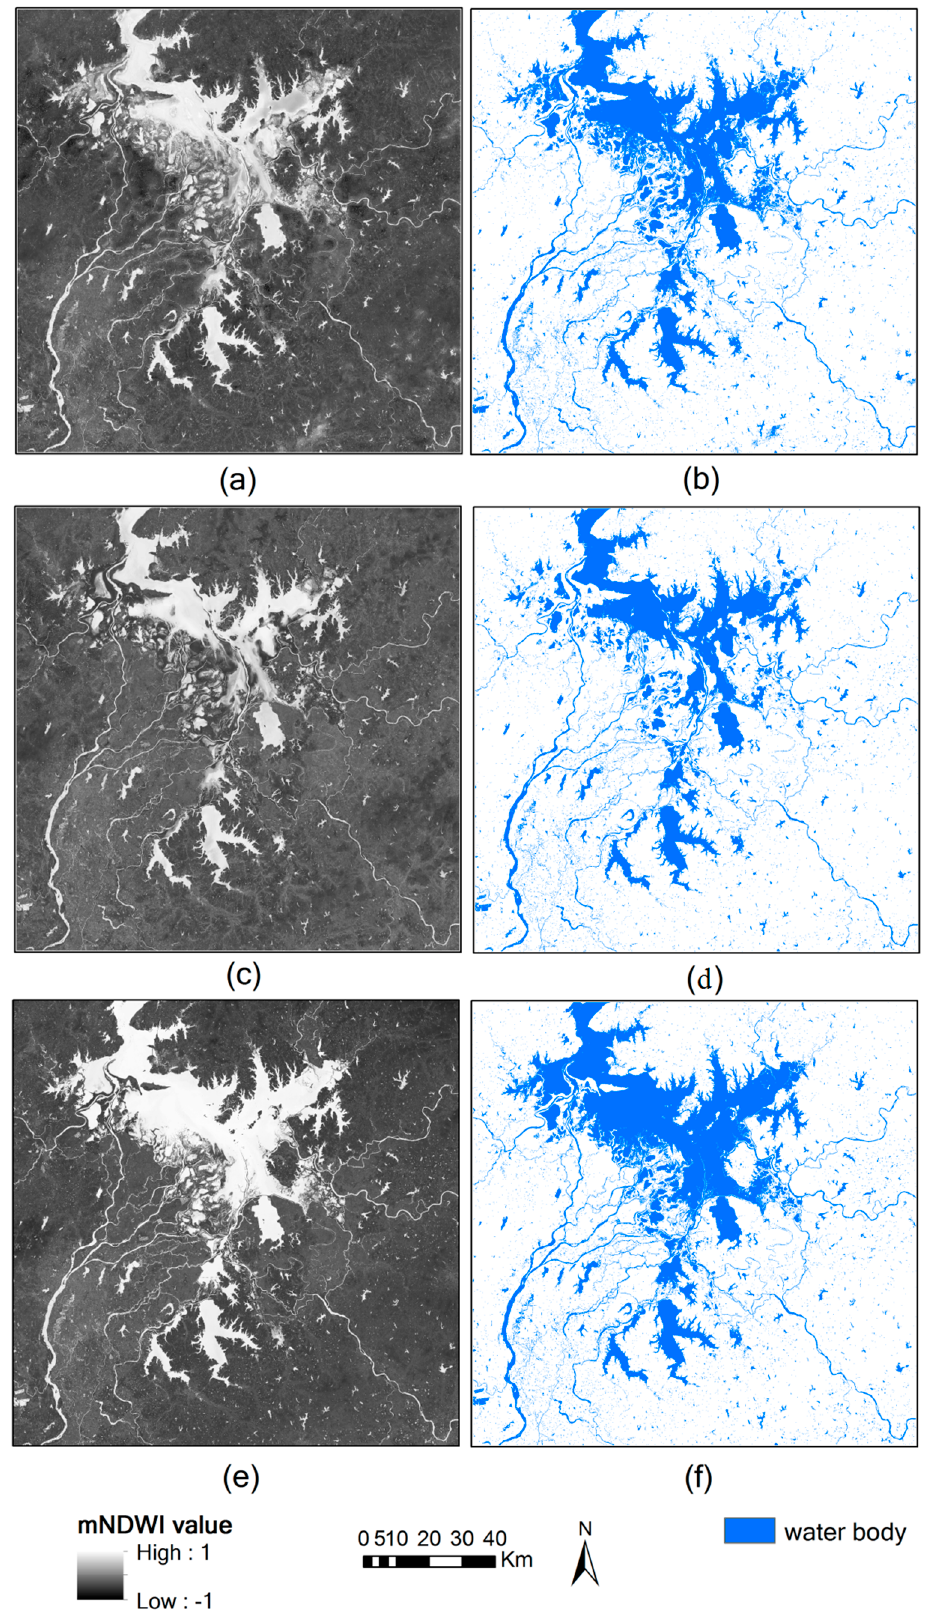
Figure 4. ( a ) mNDWI image derived by IB approach; ( b ) mNDWI image derived from actual Landsat; ( c ) water map derived from BI approach; ( d ) BI mNDWI image derived by BI approach; ( e ) water map derived from IB approach; ( f ) water map derived from actual Landsat.